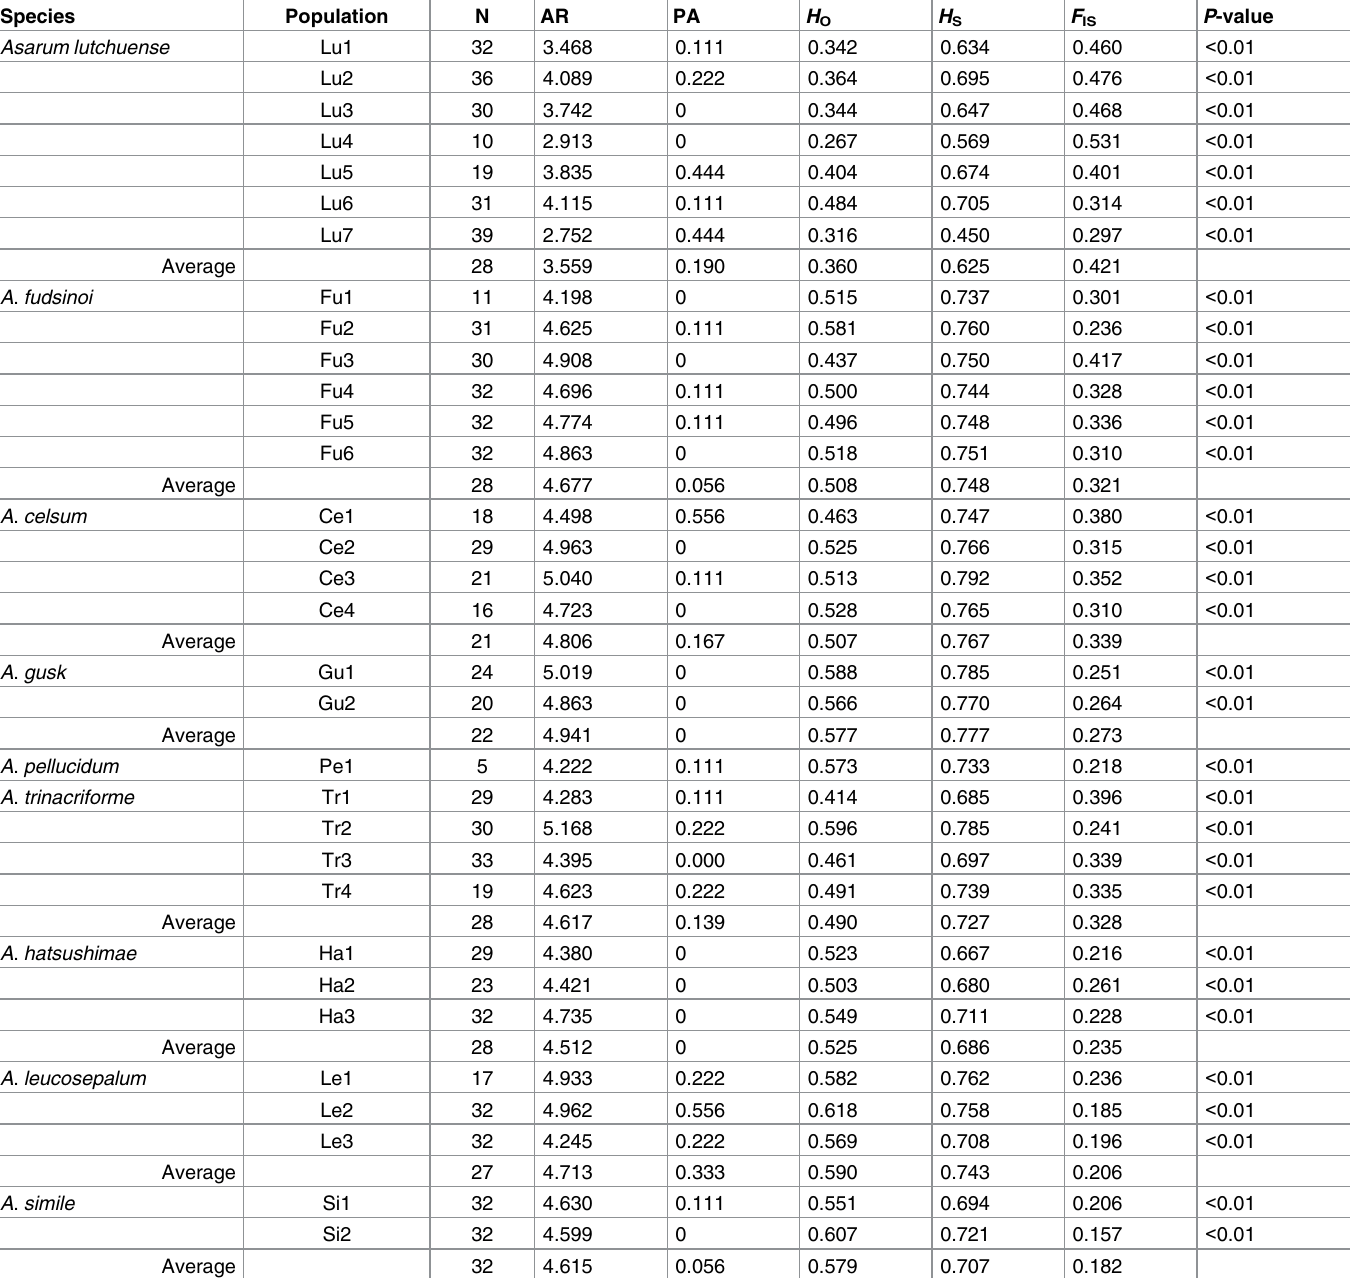
Table 2. Estimation of genetic diversity in 32 populations of nine Asarum